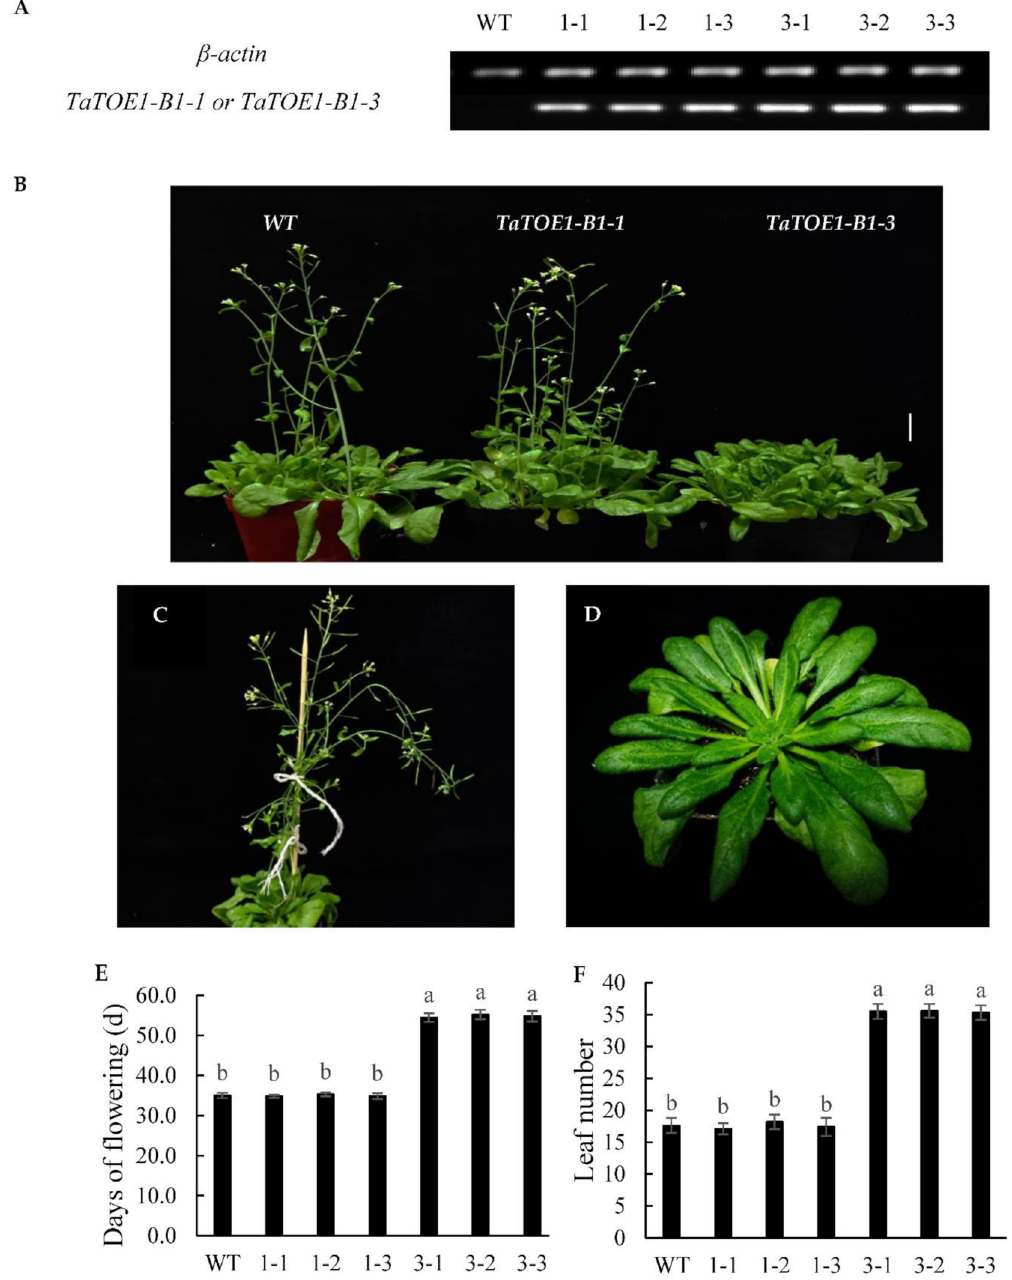
Figure 3. Phenotypic identification of Arabidopsis transgenic lines. ( A ) Gene expression analysis of TaTOE1-B1-1 and TaTOE1-B1-3 . WT, wild-type; 1-1, 1-2, 1-3: three lines of transgenic TaTOE1-B1-1 ; 3-1, 3-2, 3-3: three lines of transgenic TaTOE1-B1-3 ; ( B ) Phenotype of TaTOE1-B1-1 and TaTOE1-B1-3 transgenic lines under long-day conditions (bar = 2 cm); ( C ) WT line at 49 days; ( D ) TaTOE1-B1-3 transgenic line at 49 days; ( E ) Days of flowering; ( F ) Number of rosette leaves. Data presented in ( E , F ) are means ± SD of each line ( n > 10). Different lowercase letters above bars indicate significant difference at p <